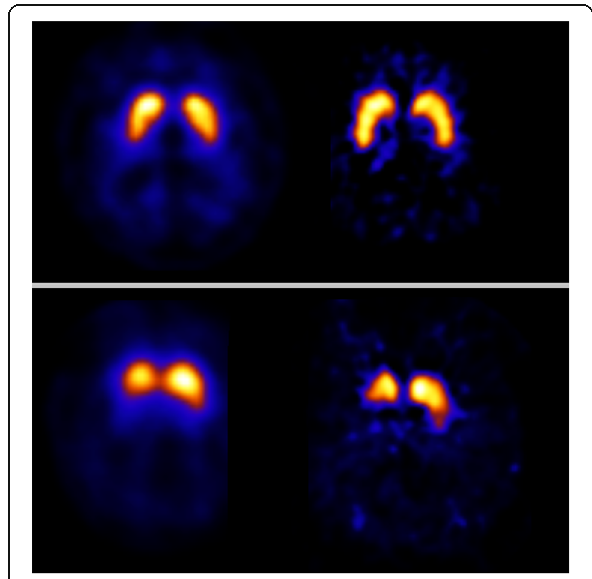
Fig. 1 [ 123 I]FP-CIT SPECT scans acquired on the NeuroFocus and InSPira. Representative image of a [ 123 I]FP-CIT SPECT scan rated as “ normal ” (upper panel), and as abnormal (PD-like) (lower panel) on both systems. Images on the left and right were acquired on the NeuroFocus and InSPira, respectively. Images are displayed in radiological orientation (left is right)